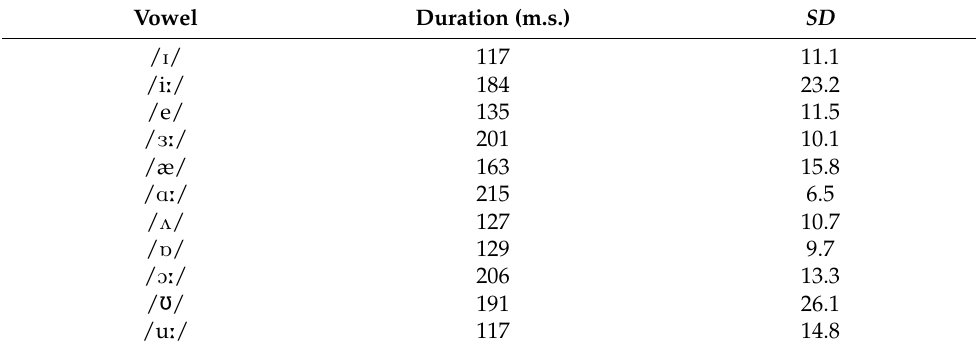
Table 2. Duration of RP vowels.